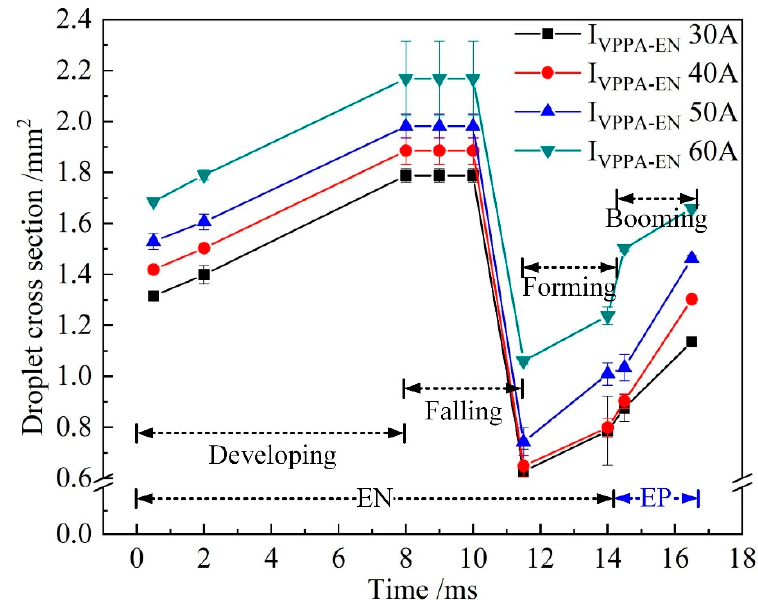
Figure 8. The evolution of droplet cross section when I VPPA-EN is varied and I MIG-EN is fixed at 70 A.